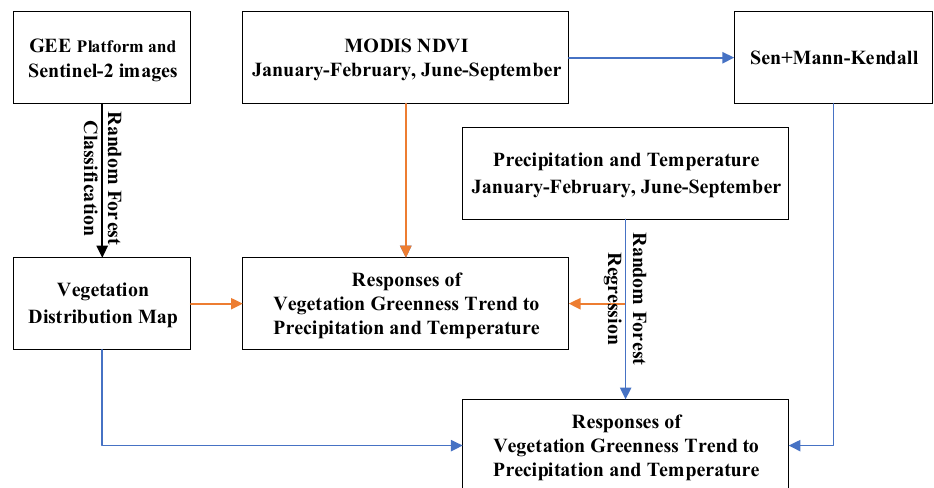
Figure 2. Flowchart of the methodology.